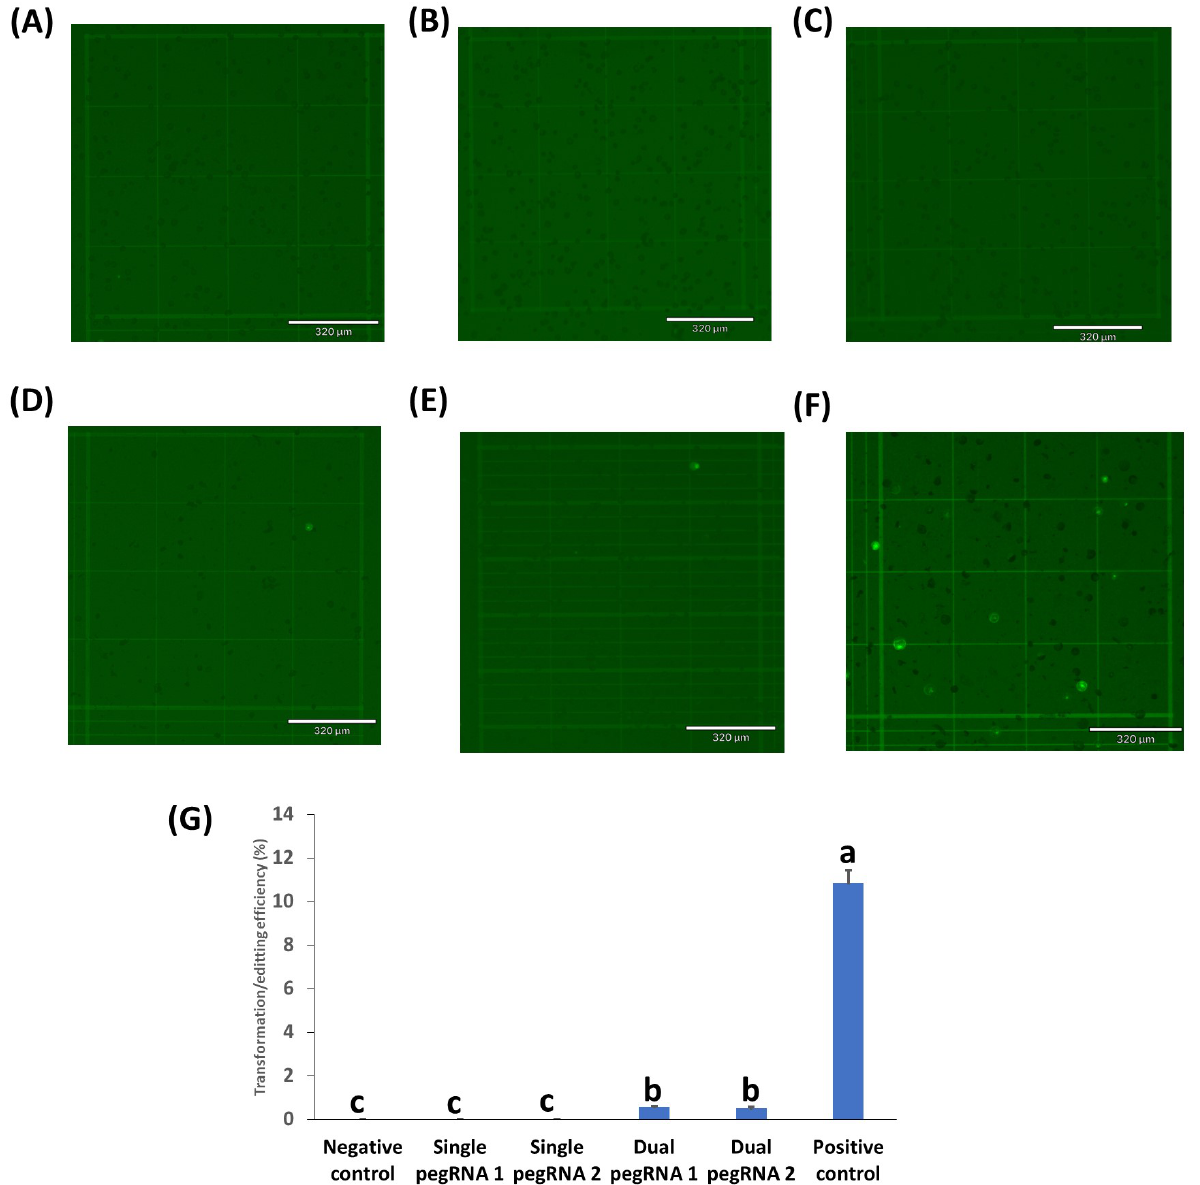
Figure 5. Prime editing in chickpea protoplasts transformed using single or dual pegRNAs containing vectors. ( A ) negative control (no GFP plasmid/prime editing vectors); ( B ) protoplasts with single pegRNA1 containing vector; ( C ) protoplasts with single pegRNA2 containing vector; ( D ) protoplasts with dual pegRNA1 containing vector; ( E ) protoplasts with dual pegRNA2 containing vector; ( F ) positive control (protoplasts with CmYLCV_GFP vector); ( G ) transformation efficiency (TE) of protoplasts transformed with different prime editing vectors. TE was evaluated after incubation in 50% PEG solution with 60 µ g plasmid DNA of each prime editing vector. Values represent means ± SE (n = 6). The different letters indicate significant differences at p < 0.05. Scale bar length for all pictures was 320 µ m. Micrographs under the bright field are shown in Supplementary Figure